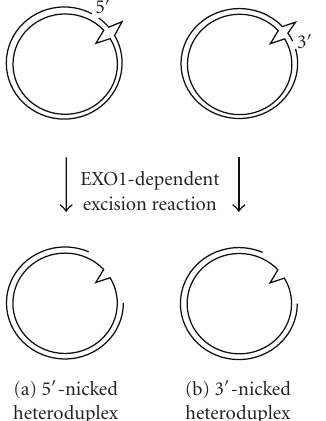
Figure 2: Bidirectionality of eukaryotic MMR. The 5 (cid:2) -nicked (a) and 3 (cid:2) -nicked (b) heteroduplexes are used as model substrate. The shorter path is chosen to remove the mismatched base. The 5 (cid:2) –3 (cid:2) exonuclease activity of EXO1 is required for excision reaction in both 5 (cid:2) - and 3 (cid:2) -nicked